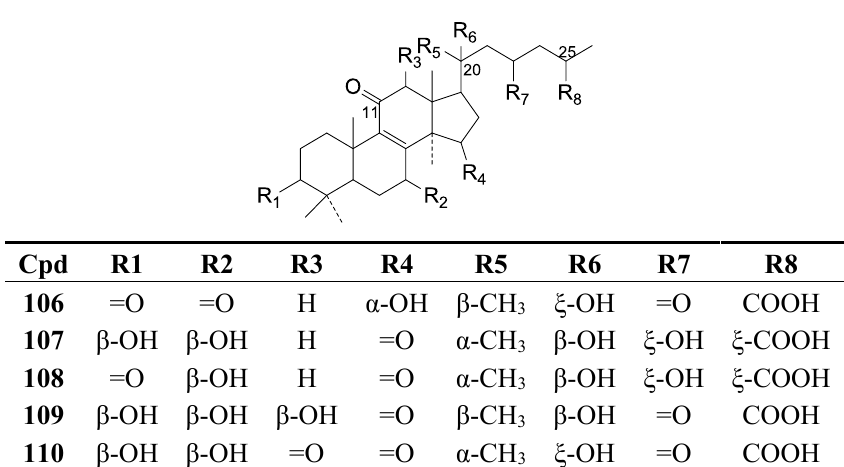
Figure 7. Structures of compounds 106 ‒ 110